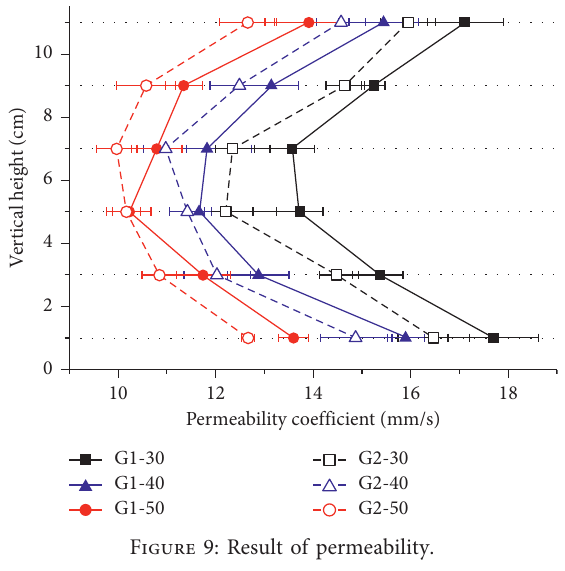
Figure 9: Result of permeability.